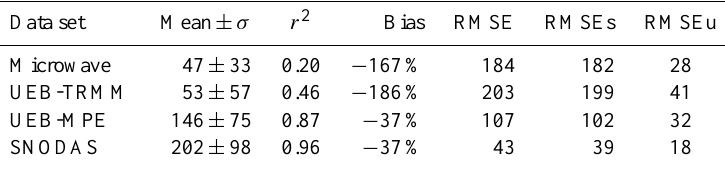
Table 4. Statistical summary of the comparison between the SWE products and the SNOTEL data sets. The last row is the statistics summary of comparison between the 0.05 ◦ resolution SNODAS and the point SNOTEL SWE.